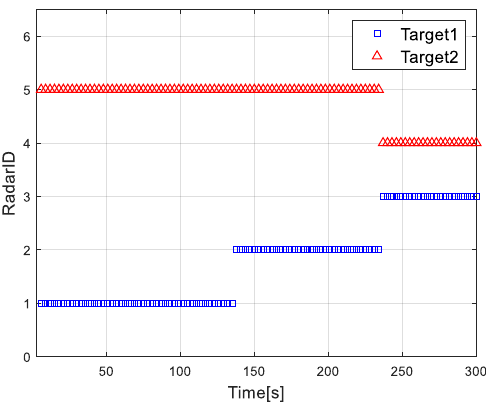
Figure 2. Assignment result between radar and target in radar network.